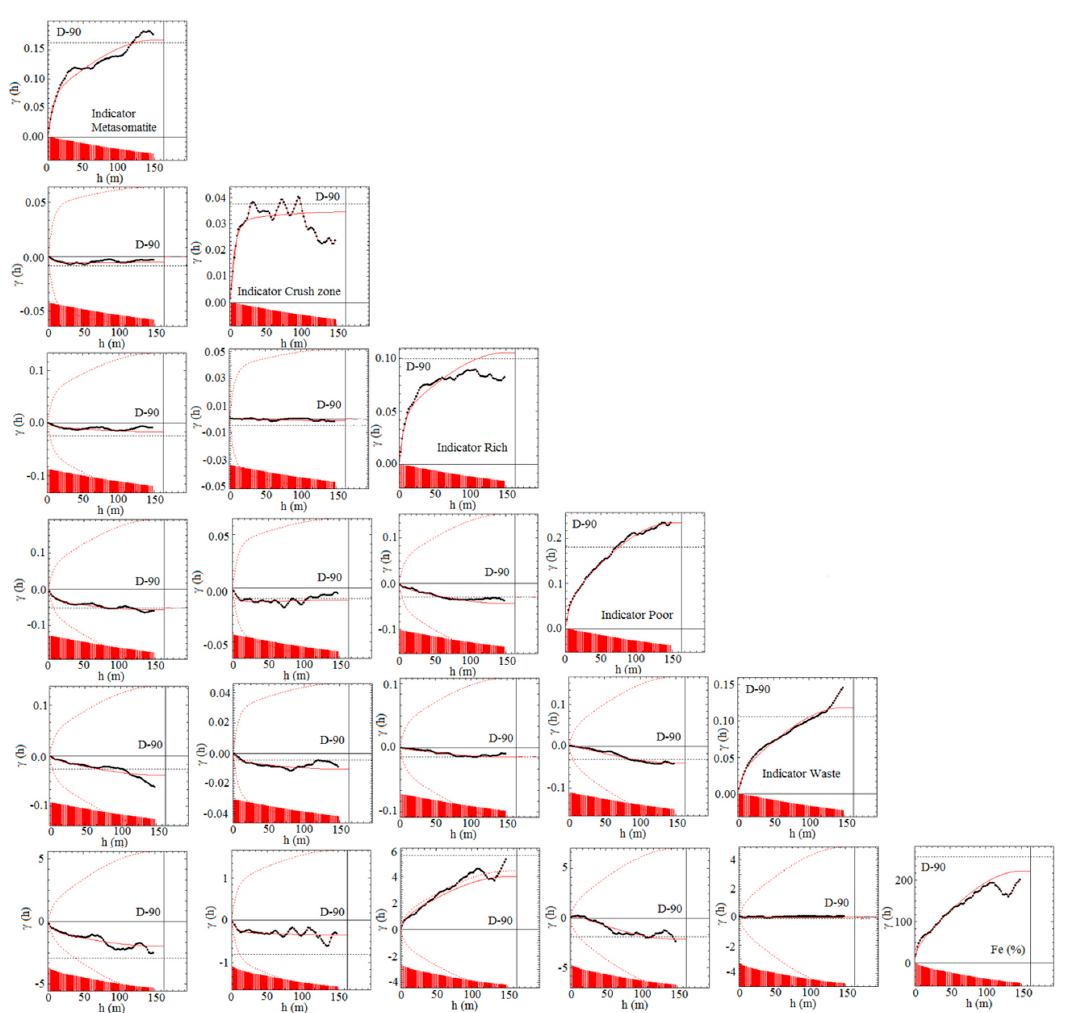
Figure 8. Sample and modeled variograms of indicators and Fe (%) (direct and cross variograms): Regularized 2.0 m samples in vertical direction.